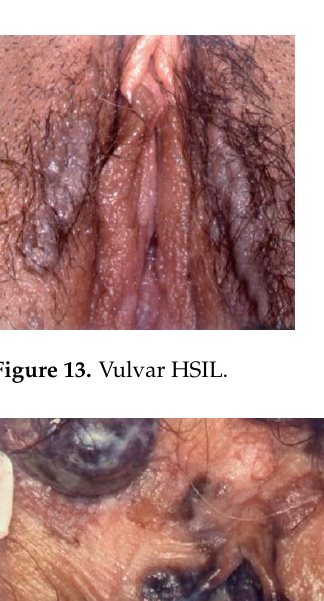
Figure 12. Nevus. Figure 12. Nevus.